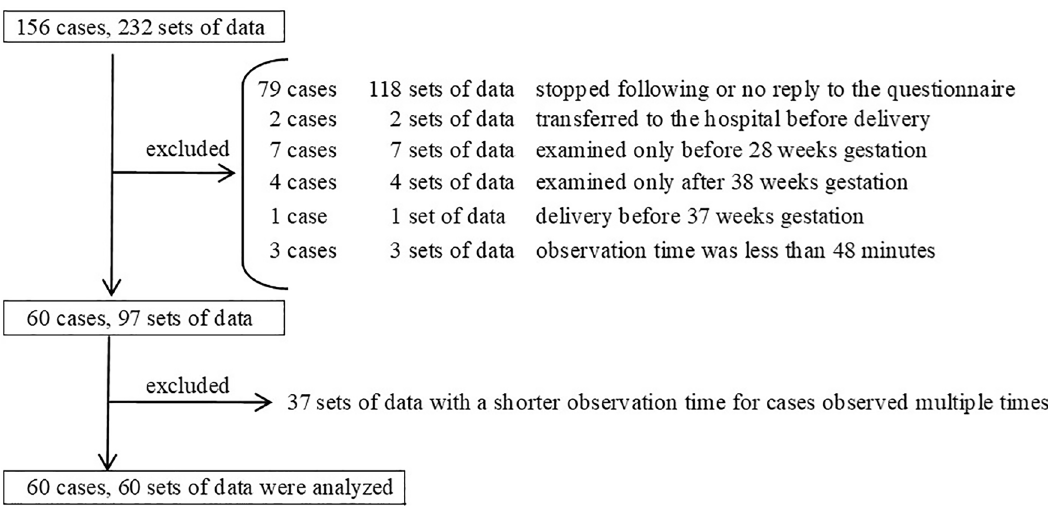
Figure 1. Population